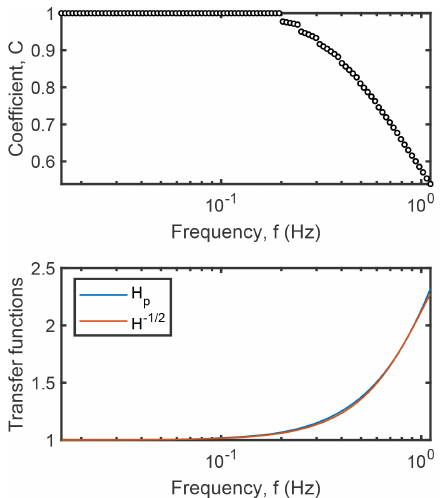
Figure 1. Top: the value for the proportionality constant C ( t lpf = Cτ ) obtained when approximating H p ≈ 1 / quency ranges. Bottom: H p and 1 / portionality t lpf = 0 . 63 τ . See Sect. 4.1 for more